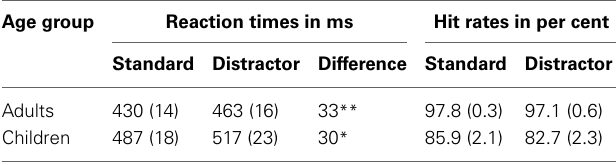
Table 1 | Behavioral results: reaction time and hit rate results for both age groups (adults; children) and stimulus types (distractor; standard).